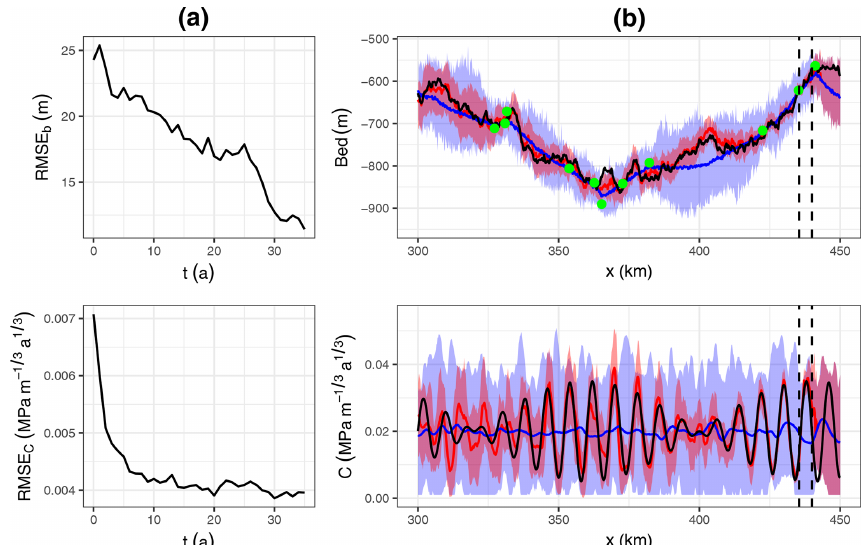
Figure 3. (a) RMSE between the reference and the analysed ensemble mean for the bed and friction coefficient. (b) For the bed and friction coefficient, the reference is shown in black, the synthetic bed measurements in the top panel are shown as green dots, the ensemble mean before assimilation is in blue and at t = 35a in red. The shading shows the ensemble spread between the minimum and maximum values, before assimilation (blue) and at t = 35a (red). The dashed vertical lines show the GL position at t = 0 and t =